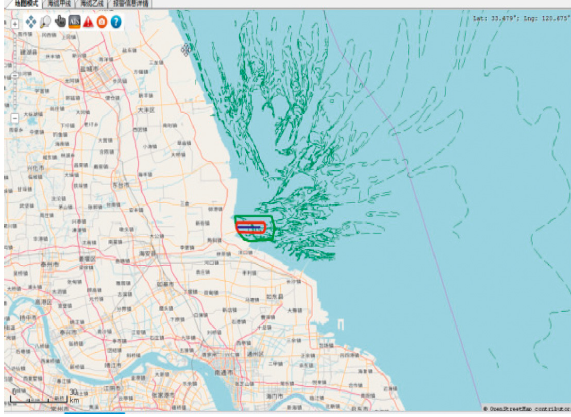
Figure 11: Operation map mode